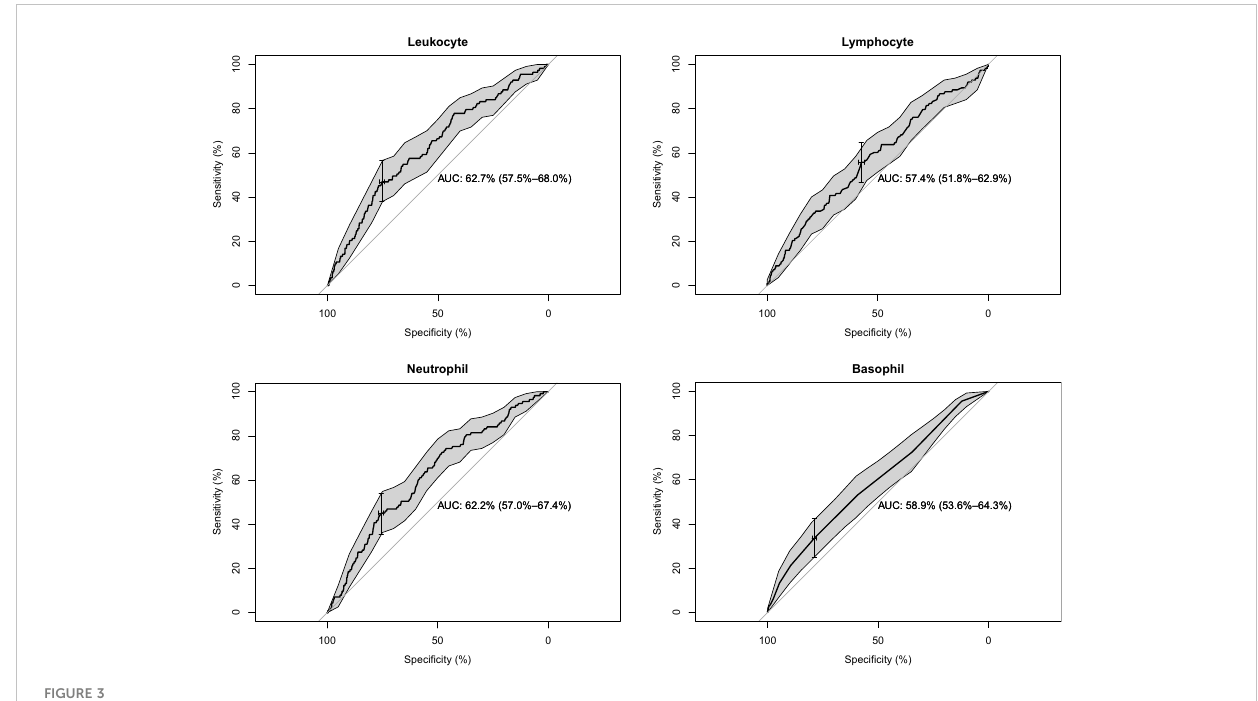
FIGURE 3 AUCs and con fi dence intervals of leukocyte, lymphocyte, neutrophil, and basophil.